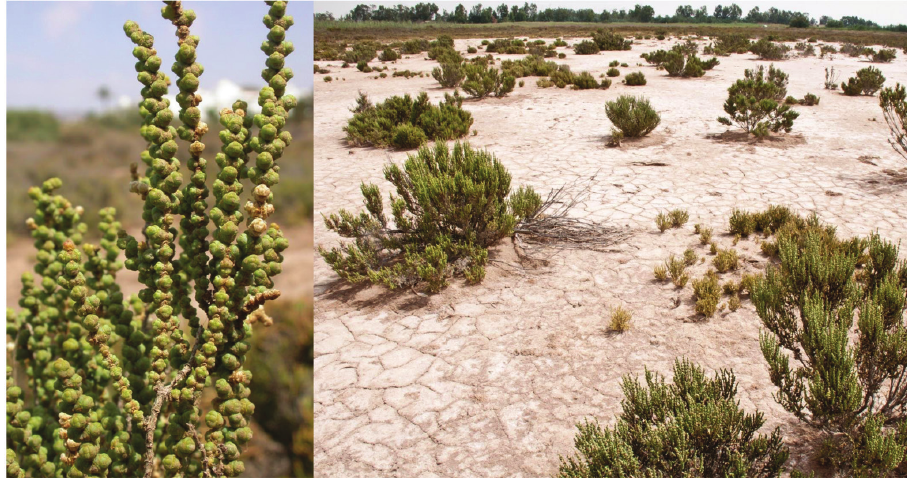
Figure 5. Halocnemum cruciatum photographed in San Juan de los Terreros (Almería, Spain, photograph by A. Lahora, on the left) and in El Hondo (Alicante, Spain, photograph by L. Serra, on the right).